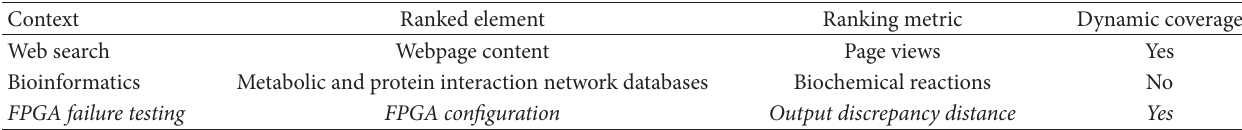
Table 1: Analogy of FPGA testing characteristics with